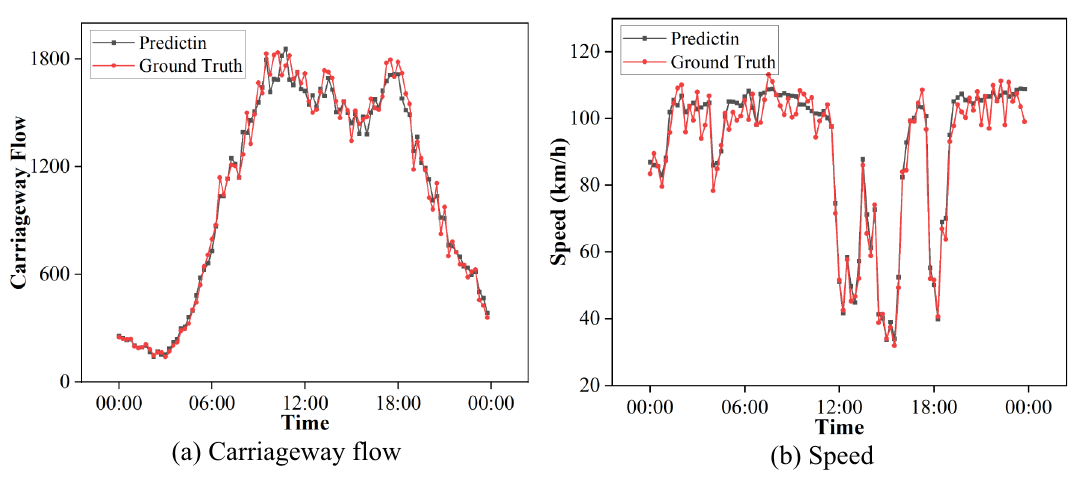
Figure 7. Link prediction for carriageway flow and